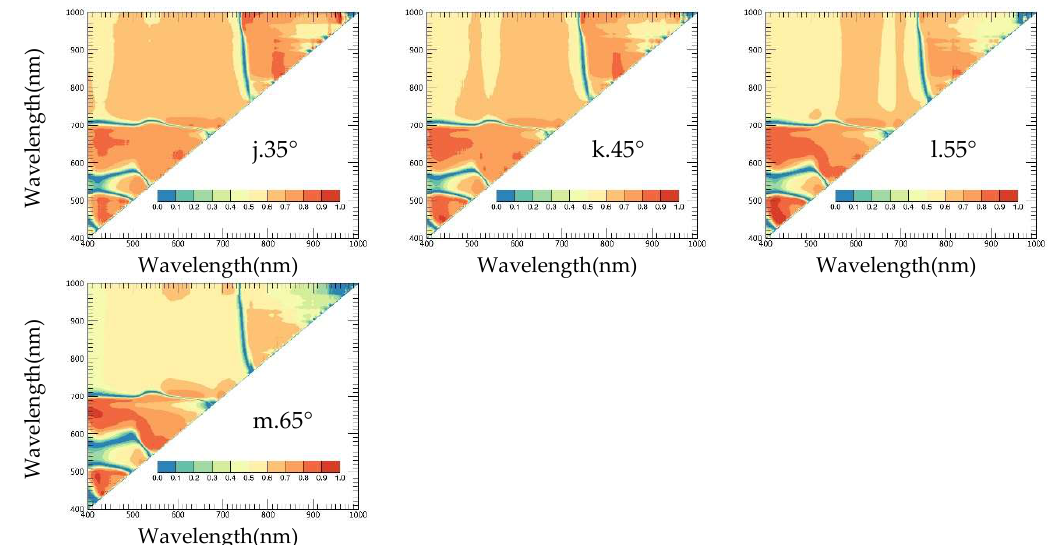
Figure 5. Contour maps of coefficients of determination (R 2 ) between NDSI(x,y) (x and y are the wavelengths on the corresponding axes) and the ground measured LAI for thirteen VZAs in PP for the planophile variety based on in-situ measurements. The color bar shown in each graph denotes the R 2 value of the linear relationship between LAI and NDSI(x,y) (the whiter the image, the higher the R 2 ). Subtitle a.-m. shown in each graph denotes observation angle.